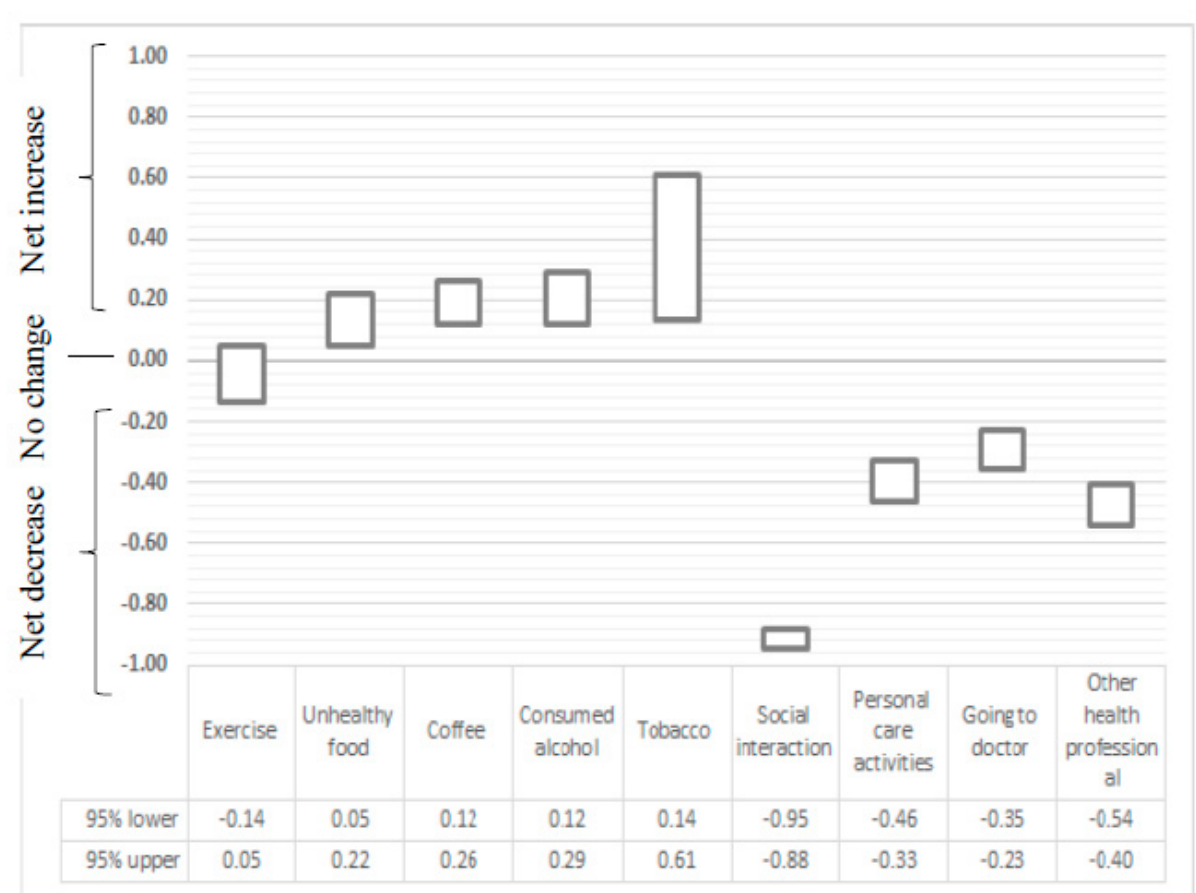
Figure 1. Average net change in behaviours reported by respondents (95% confidence interval) Decreased behaviours were coded as –1, unchanged as 0 and increased behaviours as +1.